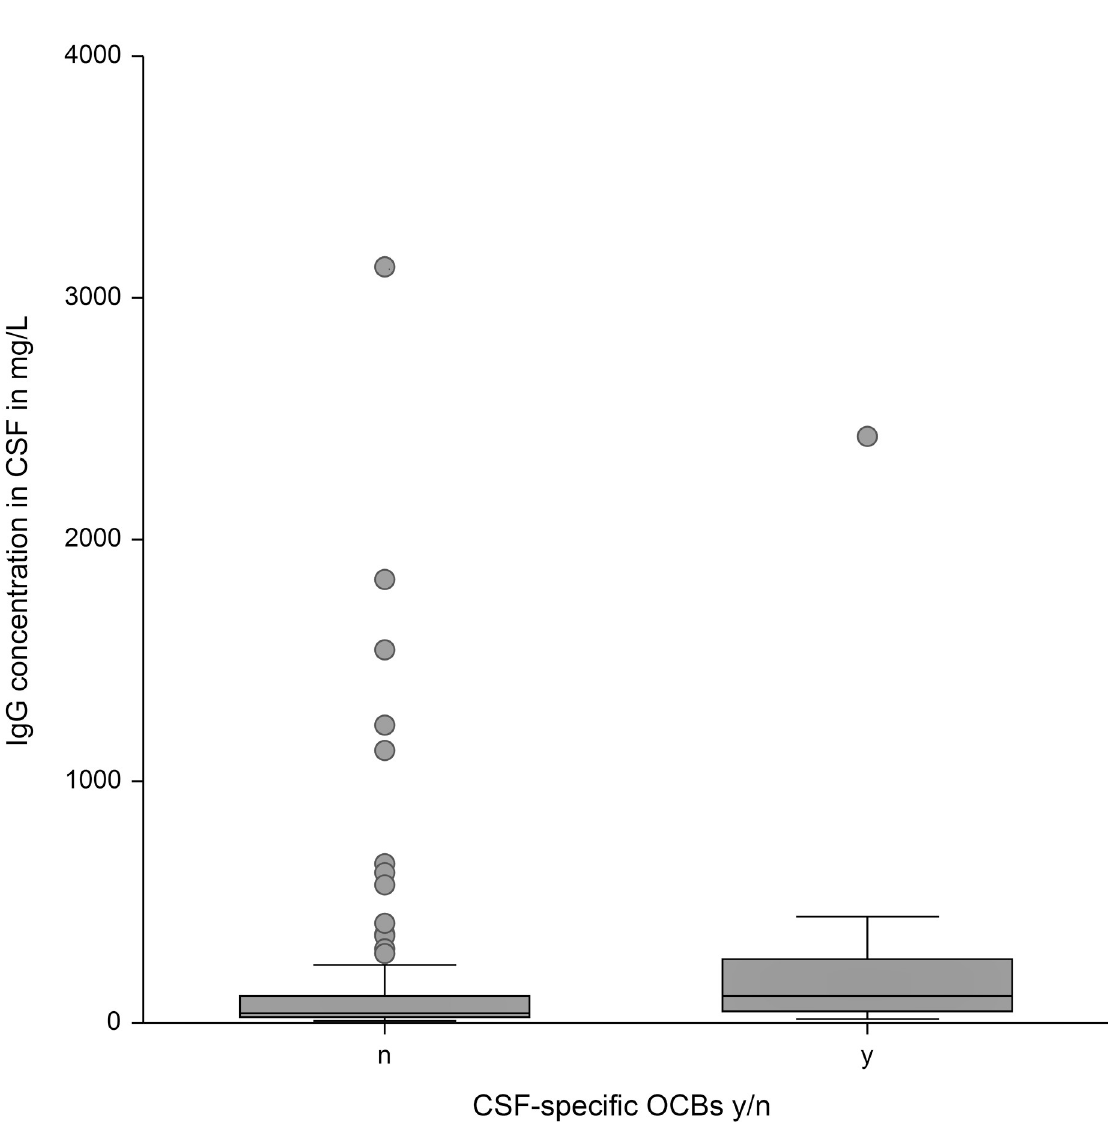
Fig 1. Association between IgG concentration in CSF and presence/absence of CSF-specific OCBs. An increased IgG concentration in CSF was significantly associated with the presence of CSF-specific OCBs (p < .01). IgG = immunoglobulin G, CSF = cerebrospinal fluid, OCB = oligoclonal band, y = yes, n =